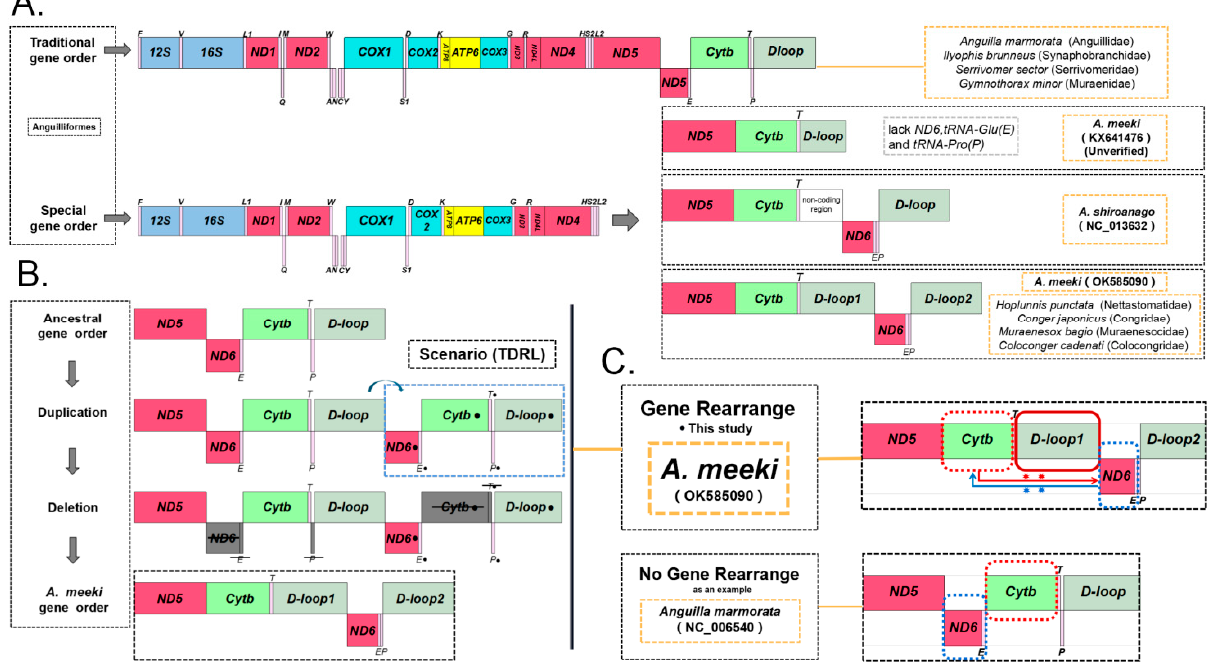
Figure 7. Analysis of the A. meeki mitochondrial gene rearrangement. ( A ) Structure of the mitochondrial genome and gene rearrangement of A. meeki; ( B ) replication and random deletion during gene rearrangement; ( C ) structural comparison of the gene rearrangement and non-gene